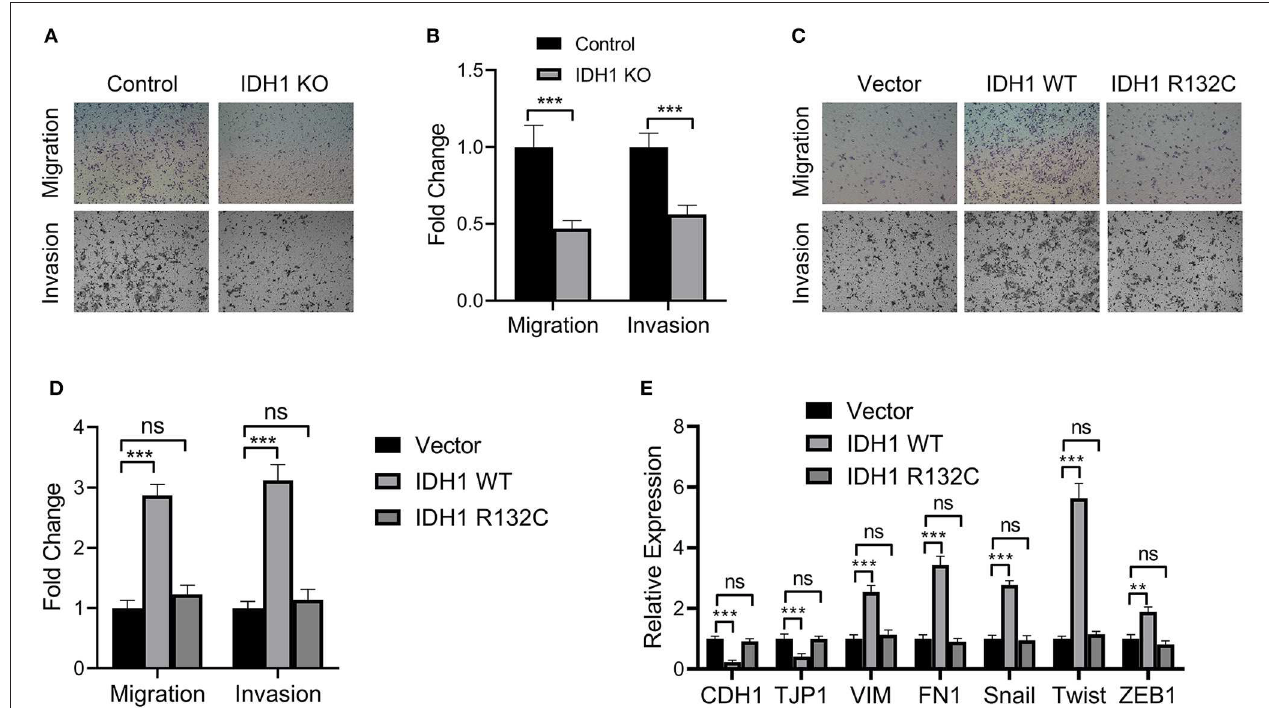
FIGURE 3 | IDH1 promoted cell migration and invasion and IDH1 knockout decreased cell migration and proliferation. (A) Cell migration and invasion of the REB and IDH1 KO REB cells were determined using Transwell and (B) the values in each group were shown as mean ± S.D. (C) Cell migration and invasion of the IDH1 KO REB cells transfected with vector, wildtype IDH1, or IDH1 R132C mutation plasmid and (D) the values in each group were shown as mean ± S.D. (E) qPCR was used to analyze the relative expressions of a panel of EMT relevant markers in IDH1 KO REB cells transfected with vector, wildtype IDH1 or IDH1 R132C mutation plasmid. Data were shown as mean ± S.D. ** P < 0.01, *** P < 0.001; ns indicates no significance.